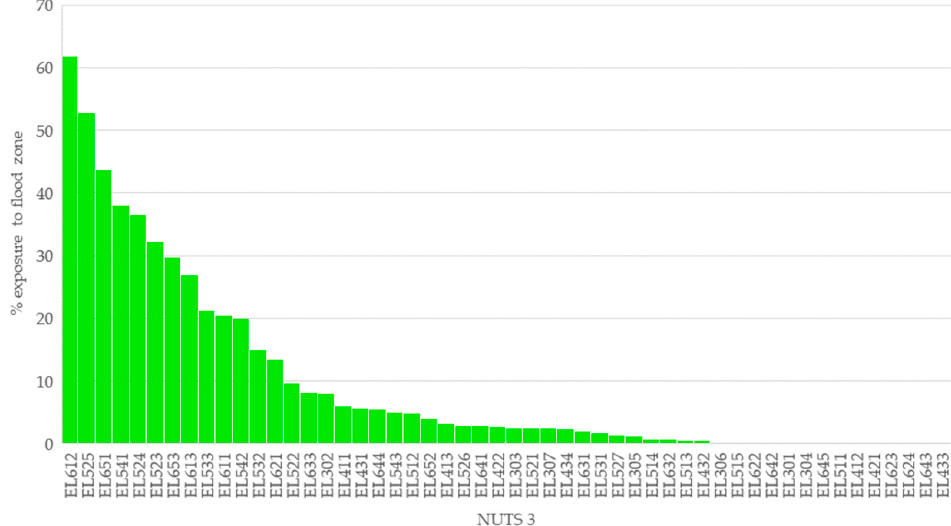
Figure 13. Graphical representation of the ratio of social infrastructure in flood zones per NUTS 3 in descending order.